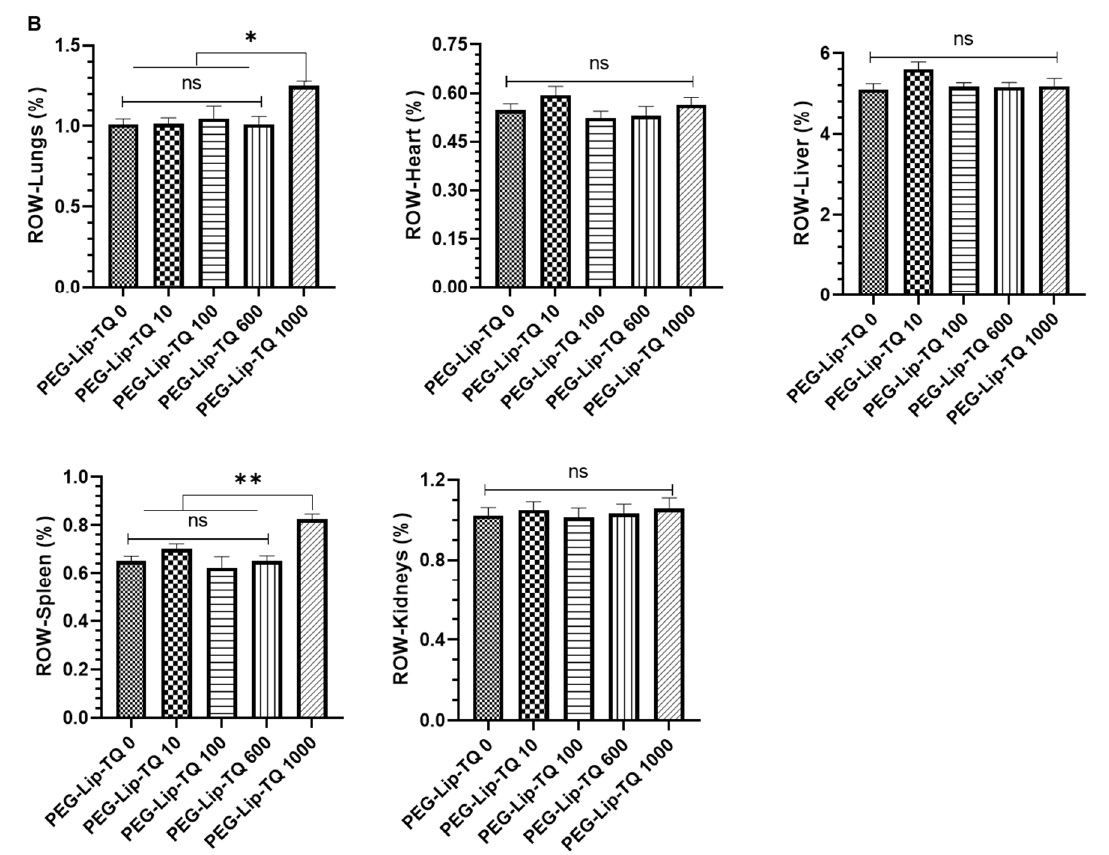
Figure 10. Effect of TQ on the relative organ weight of vital organs (lungs, heart, liver, spleen, and kidneys) in all the surviving animals from phase 1 and phase 2. The quantitative analysis of ROW from the animals exposed to ( A ) free TQ ( B ) PEG-Lip-TQ. The values are expressed as mean ± SE of three independent experiments. NS No significance within the groups, * Significant difference between the treated groups, p -value < 0.05, ** Significant difference between the treated groups, p -value < 0.001, *** Significant difference between the treated groups, p -value < 0.0001.